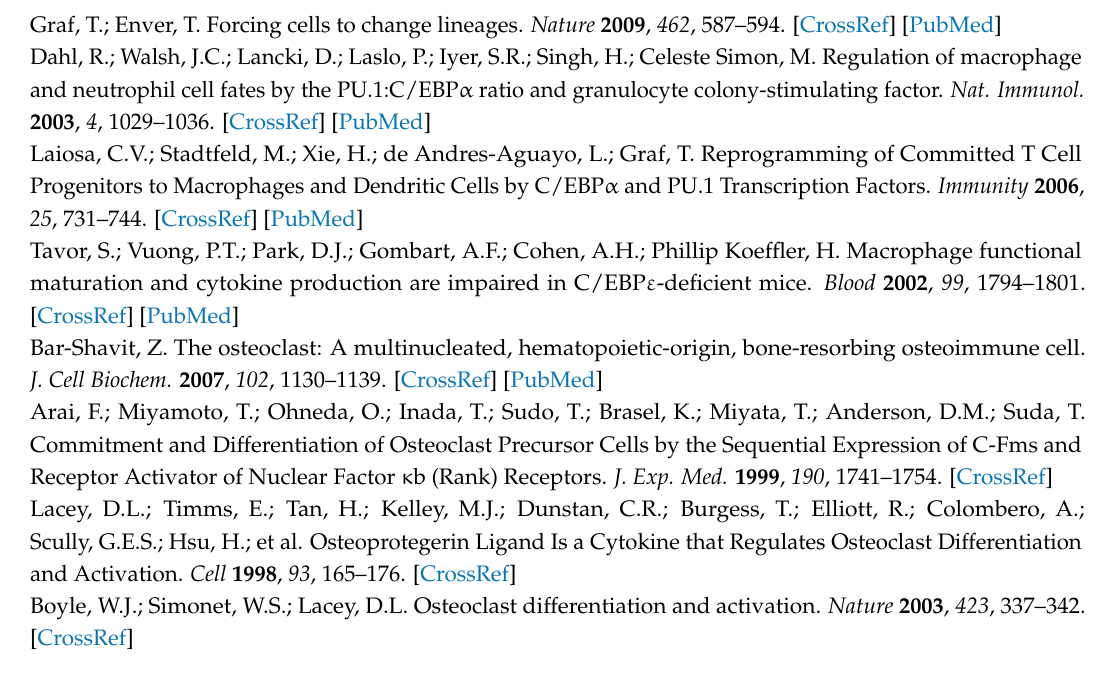
Table S1. Complete list of genes included in the PCR array transcription factor and osteoporosis in untransfected cells. Table S2. Complete list of genes included in the PCR array transcription factor and osteoporosis in NFATc1-knockdown